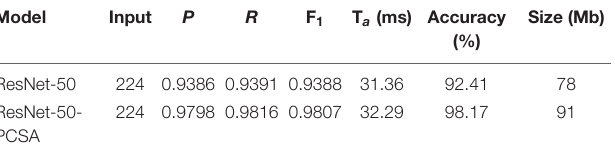
TABLE 4 | The results of ResNet-50-PCSA compared with ResNet-50.